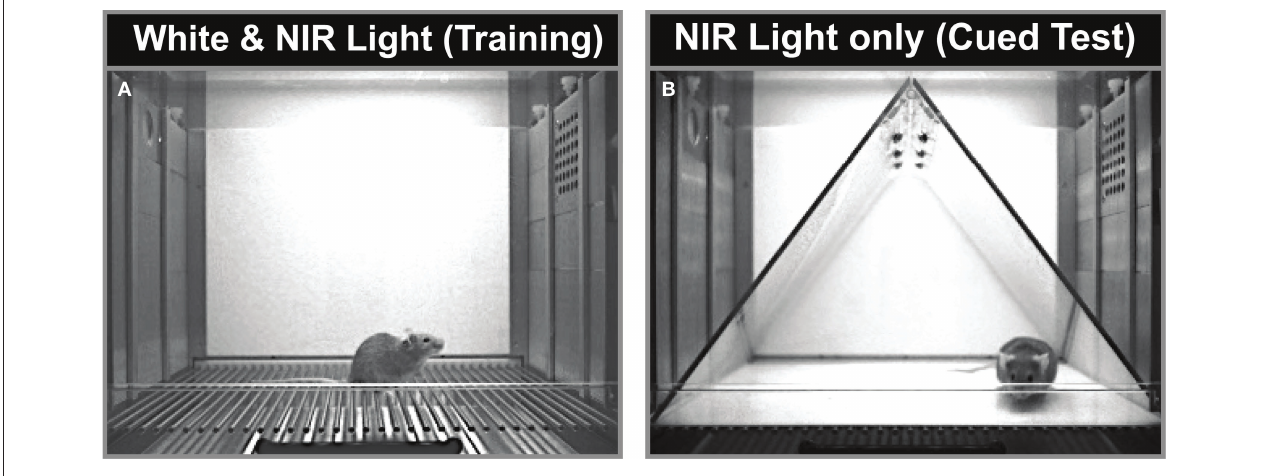
over the shock grids, a black triangular tee-pee (translucent only to NIR light, as shown), and NIR light only. The actual environment appeared to the unassisted eye as total darkness. The odor was also changed between the two